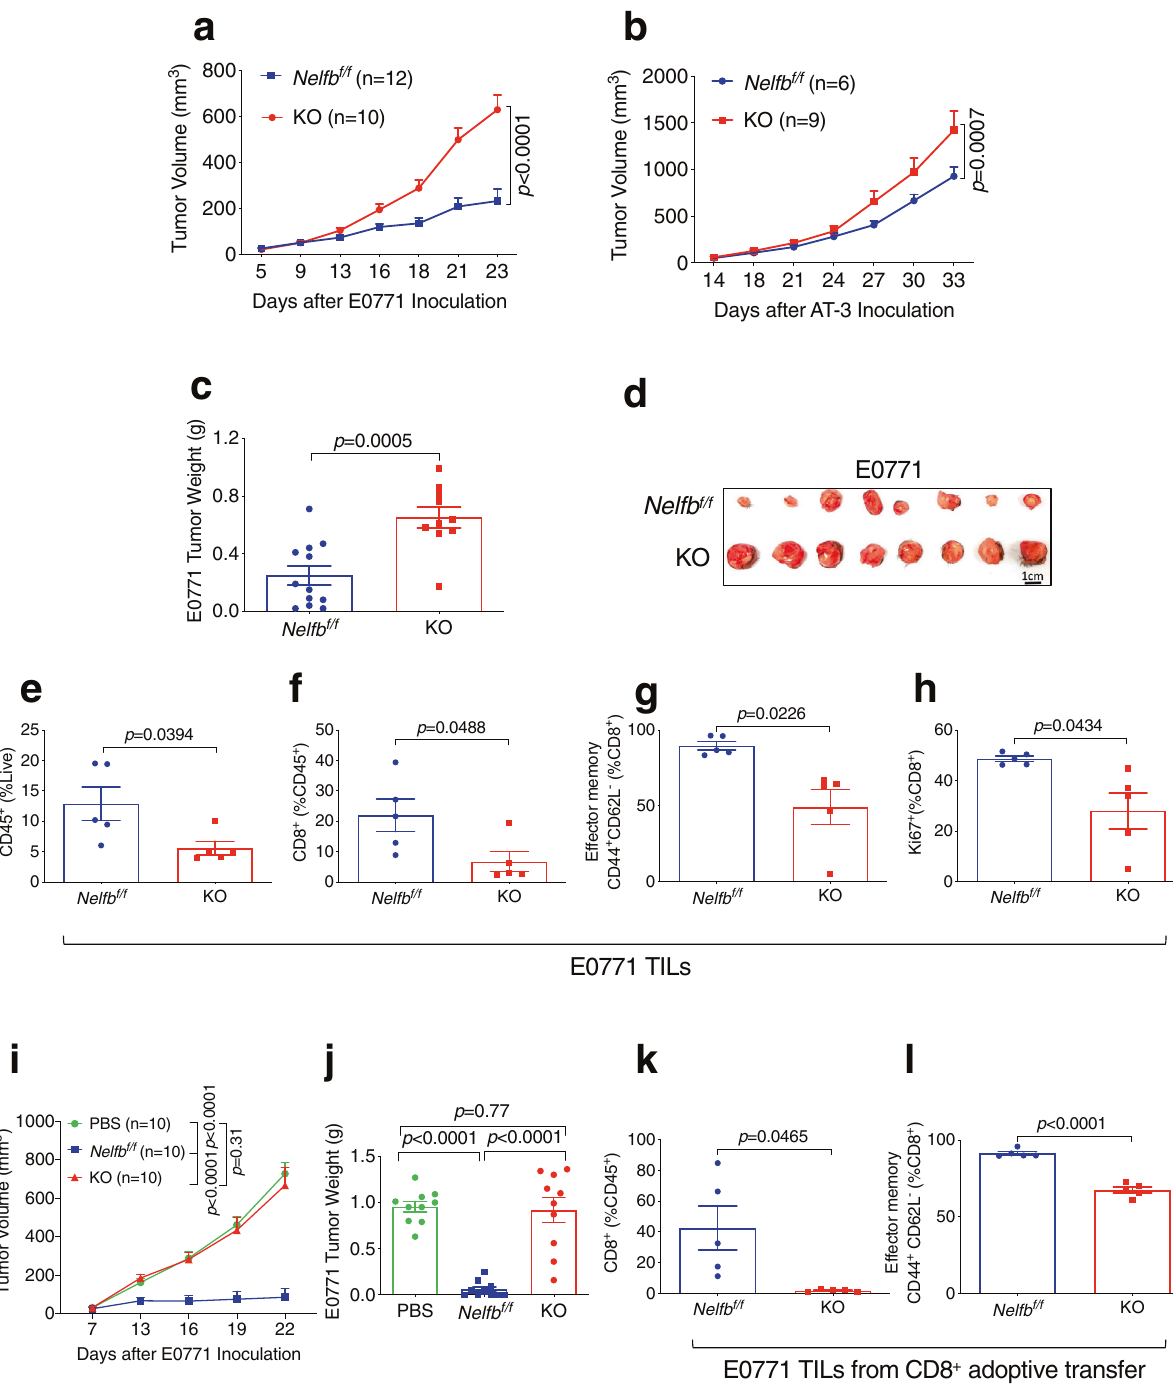
Fig. 1 Nelfb is required for CD8 + T cell-intrinsic antitumor function. a , b Growth curves of E0771 ( a ) and AT-3 ( b ) tumors in Nelfb f/f and KO mice. c , d E0771 tumor weight ( c ) and image ( d ) upon harvest in Nelfb f/f and KO mice. e – h TIL analysis for E0771 tumors in Nelfb f/f and KO mice: e CD45 + (% of all live cells), f CD8 + (% of CD45 + ), g effector memory CD44 + CD62L − (% of CD8 + ), h Ki67 + (% of CD8 + ), n = 5/group. i , j E0771 tumor growth curve ( i ) and weight ( j ) in Rag1 − / − mice receiving Nelfb f/f or KO CD8 + T cells. k , l TIL analysis for E0771 tumors in Rag1 − / − mice receiving Nelfb f/f or KO CD8 + T cells. k CD8 + (% of CD45 + ), l effector memory CD44 + CD62L − (% of CD8 + ); n = 5/group. Data were presented as mean ± SEM; Student ’ s t -test (for two groups) or one-way-ANOVA (for three or more groups). Tumor curves were compared using two-way ANOVA followed by multiple comparisons. Two-sided tests were used. Source data are provided as a Source Data fi